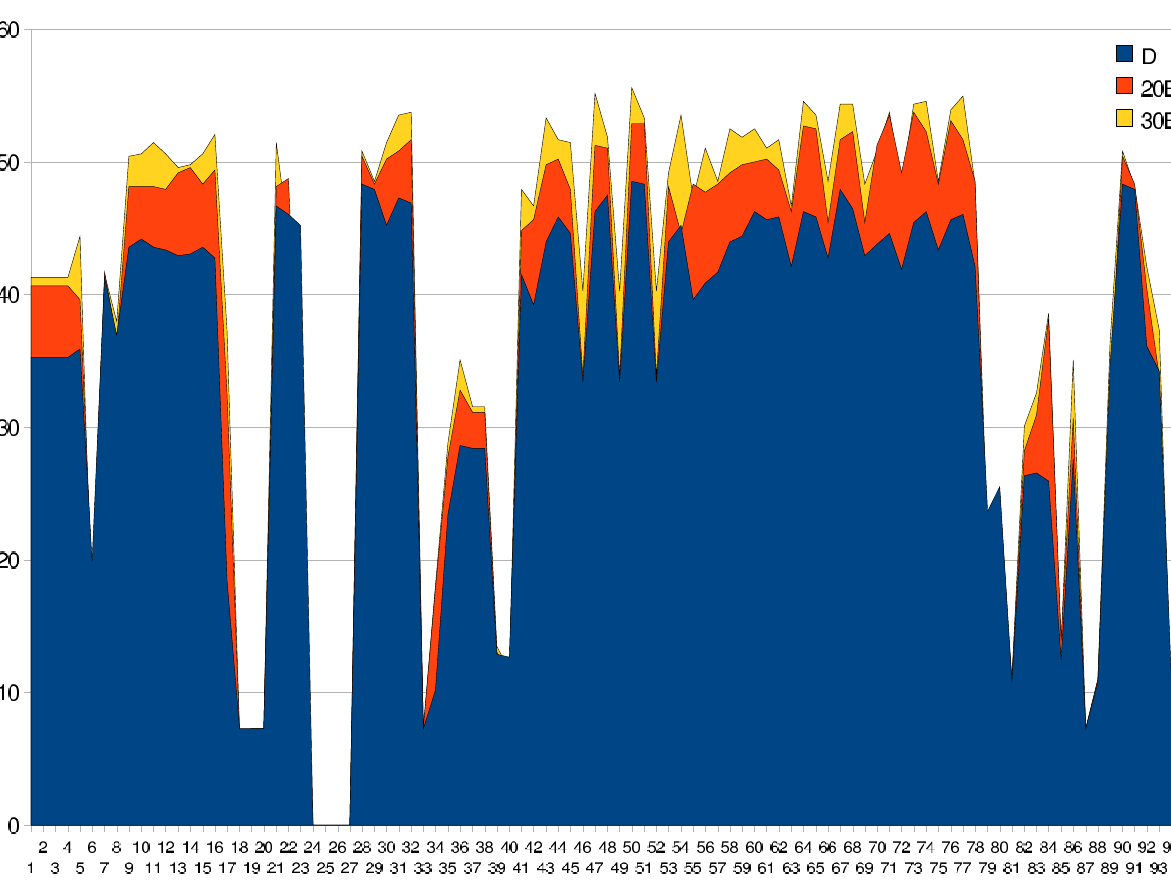
Figure 2: Plot showing the performance of each of the 96 classifier configurations on the dataset of 49 superfamilies (including multi domain proteins). Classifiers on the x axis are defined in table 1.